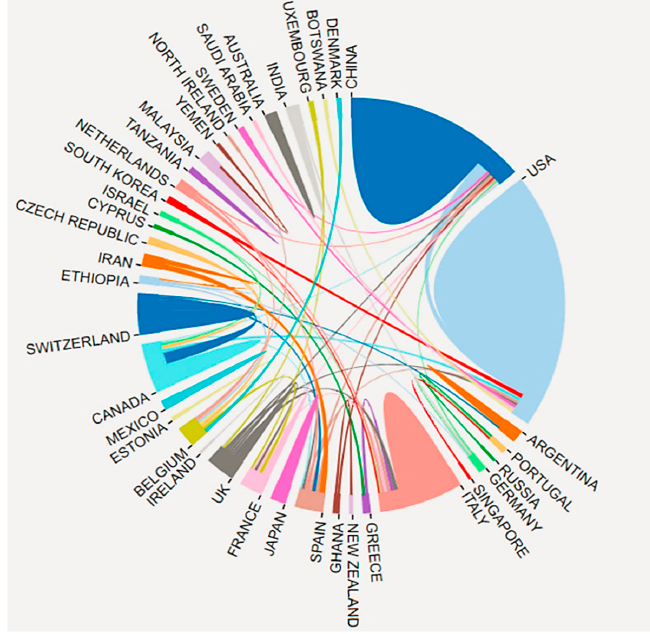
Figure 5. Network of intercountry cooperation in sprawl research. Table 2. Working reports of international agencies on sprawl measurement.